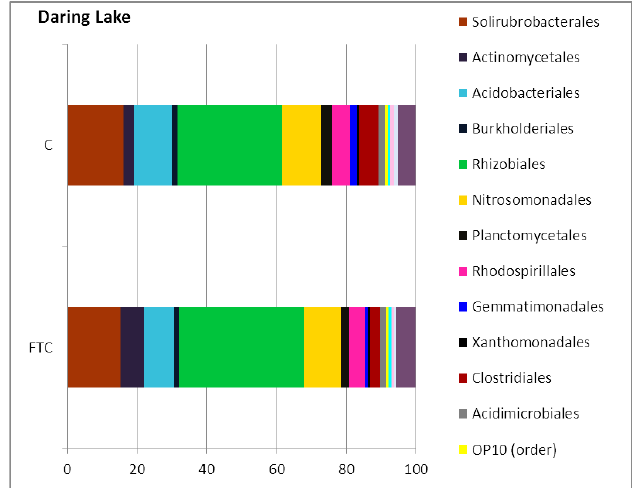
Figure 3. Bacterial phylogenetic composition within the soil assemblages of Daring Lake, Cambridge Bay and Alexandra Fjord, both before (control; C), and after multiple freeze-thaw cycles (FTC). Sequence identity was established after pyrosequencing of